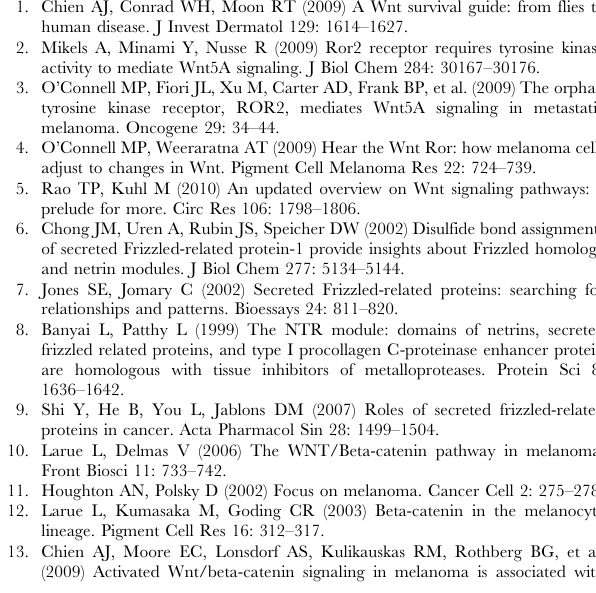
Figure S1 Fluorescence intensity measurement of basal SFRP3 protein expression in cell lines. Melanocytes and melanoma cells were analyzed for SFRP3 expression using immunofluorescence that was quantified by measuring the intensity from at least 6 images from each of 3 separate experiments. The data are given as Arbitrary Units (AU).